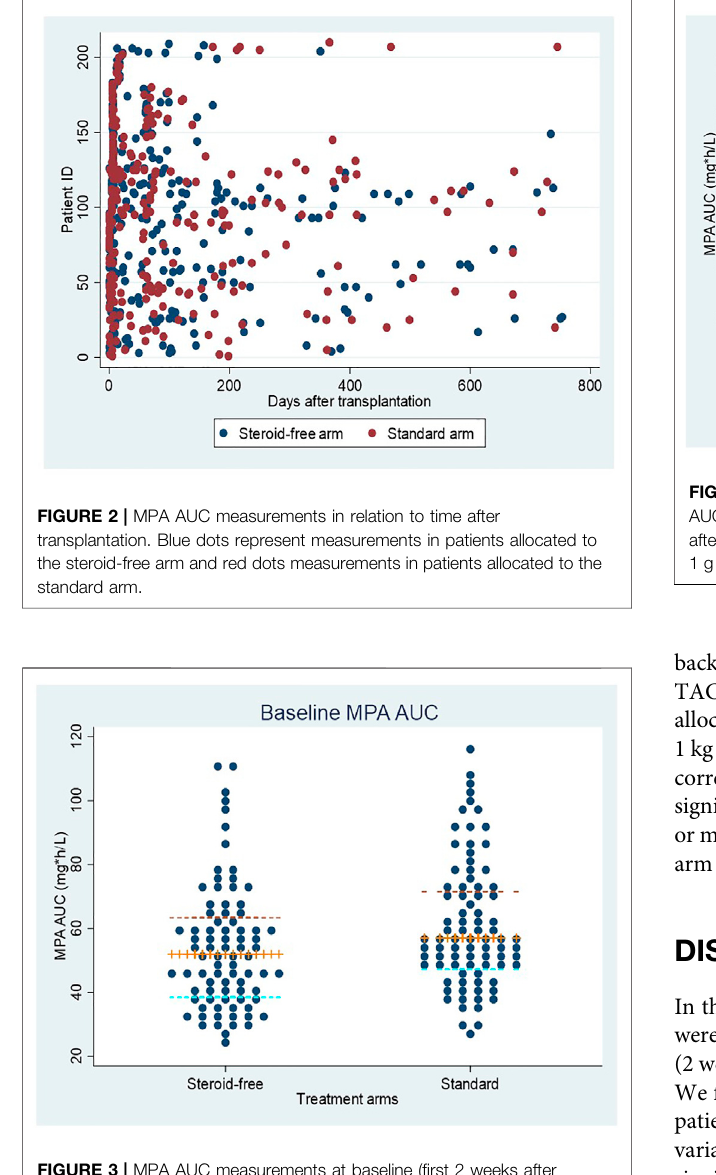
FIGURE 3 | MPA AUC measurements at baseline ( fi rst 2 weeks after transplantation) in patients allocated to the steroid-free treatment arm and the standardtreatmentarm.Allpatientsreceivedadoseofmycophenolatemofetil of 1 g twice daily. The median value and interquartile ranges are shown by the horizontal lines.